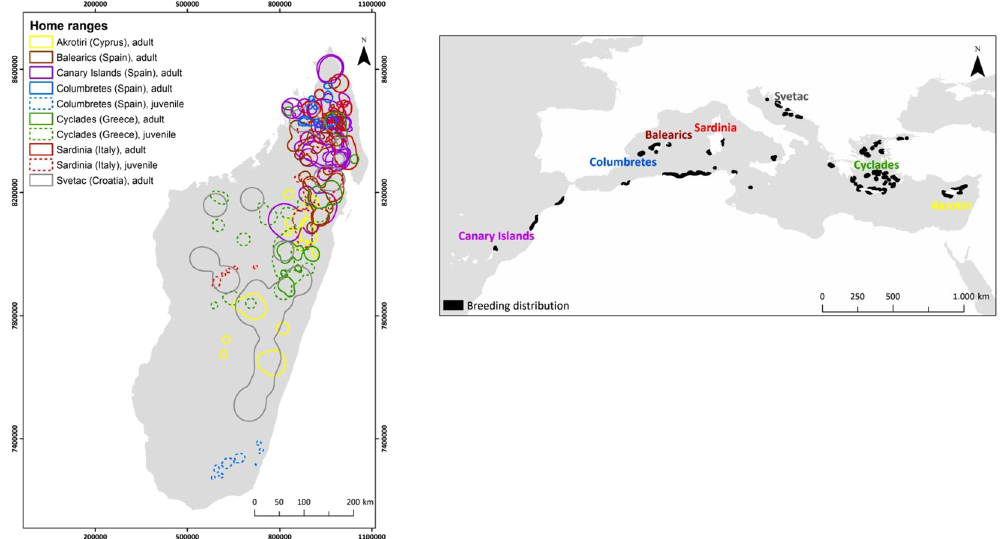
Figure 2. Home ranges of 23 Eleonora’s falcons marked in colonies spanning from the westernmost (Canaries) to the easternmost (Cyprus) breeding range of the species. The existing breeding colonies are highlighted in black (data from 87 ). Map was created with ArcGIS v10.1 (www.arcgis.com).